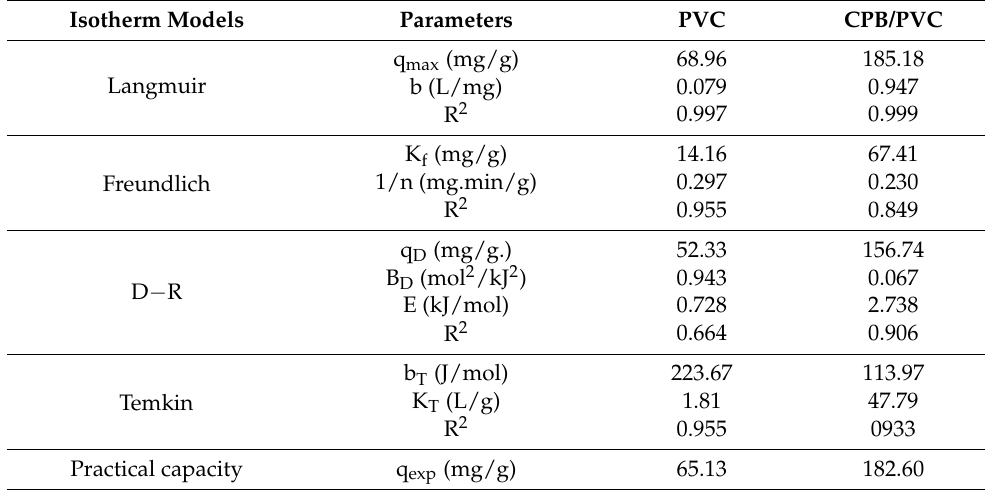
Table 3. Isotherm restrictions of isotherm modeling for REE sorption upon the PVC and CPB/PVC